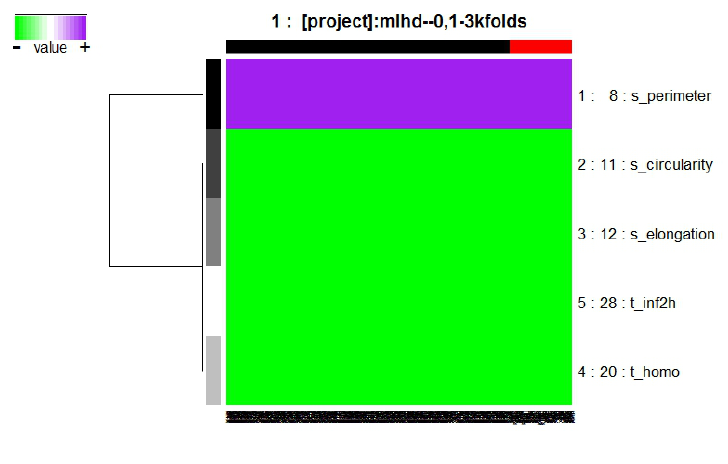
Figure 1. Model obtained from Galgo algorithm with Random Forest (RF) method.